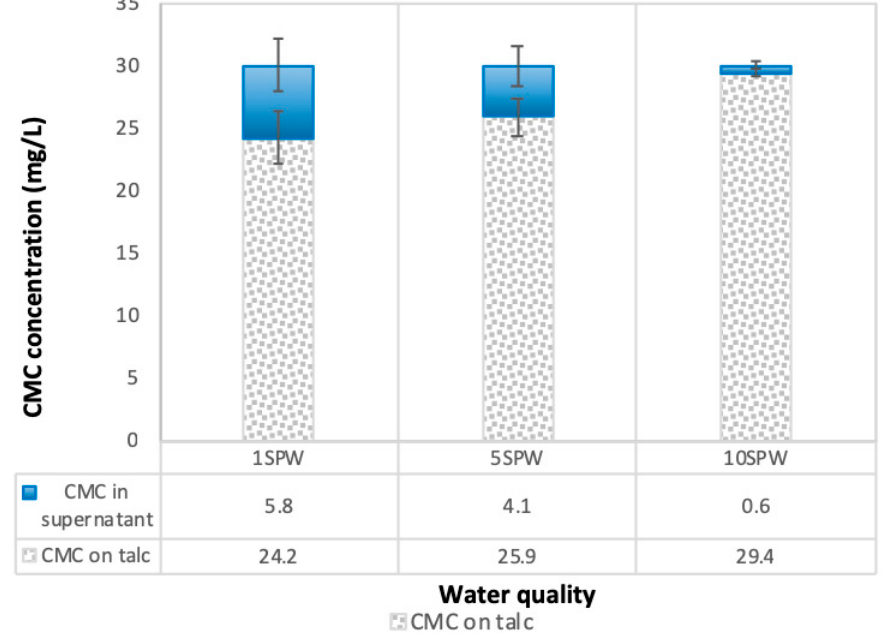
Figure 5. Total concentrations of CMC absorbed onto talc and remaining in solution as a function of the ionic strength of SPW.